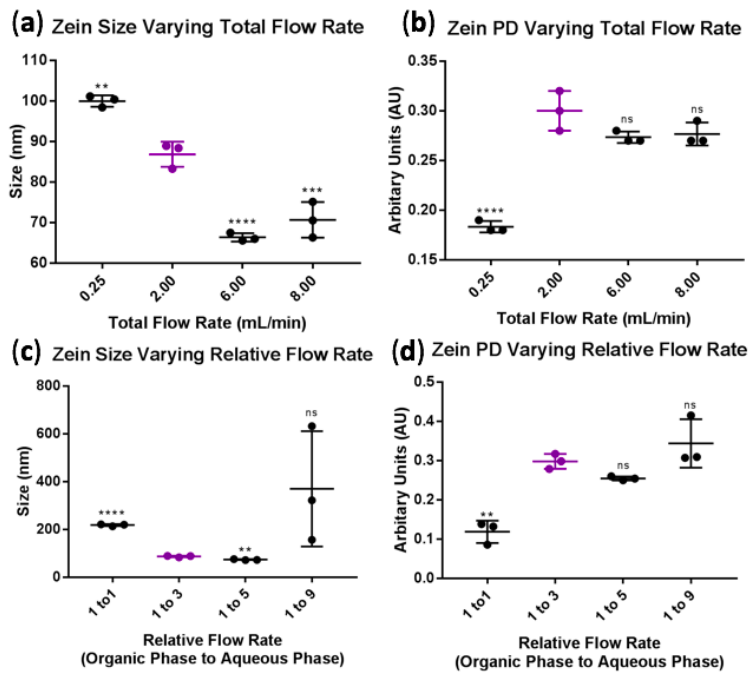
Figure 2. Changes in Zein nanoparticle (NP) diameter synthesized in the microfluidic Y junction as a function of: ( a ) Total Flow Rate (TFR); ( c ) Relative Flow Rate (RFR). Changes in Zein NP polydispersity (PD) as a function of: ( b ) TFR; ( d ) RFR.